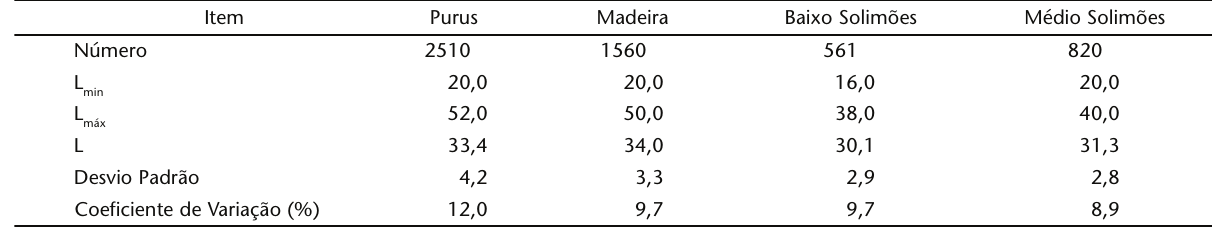
Tabela I. Estatística descritiva para a matrinxã dos rios Purus, Madeira, e Solimões (baixo e médio) nos anos 1998-1999. (L pescado medido, (L